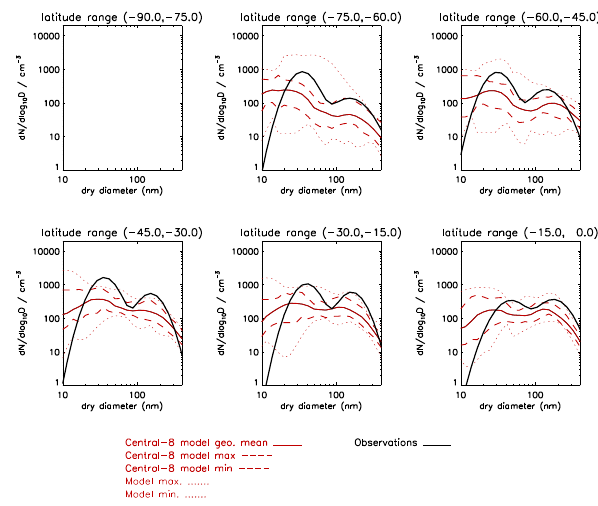
Figure 19. Southern Hemisphere annual-mean central-model sim- ulated size distributions in the marine boundary layer averaged into 15 ◦ latitude ranges to compare against the compilation of 30yr of cruise DMPS/APS measurements from Heintzenberg et al. (2000). The solid line shows the geometric mean of the central-8 models, dashed lines indicate the maximum and minimum of the central-8, while dotted lines indicate the maximum and minimum over all 12 models.